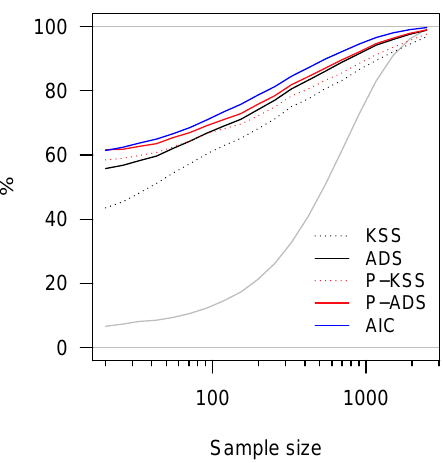
Fig. A1. Skewness-kurtosis diagram comparing the possible shapes Fig. A2. Simulation study: Number of times where the GD is se- Fig. 16. Skewness-kurtosis diagram comparing the possible shapes of the GD and WD, together with the normal of the GD and WD, together with the normal and exponential dis- Fig. 17. Simulation study: Number of times where the GD is selected as the preferred model, with the measures lected as the preferred model, with the measures KSS, ADS, P-KSS, tribution. The black line is the limit of all distributions. P-ADS and AIC. The gray line gives the rejection rate of the WD, and exponential distribution. The black line is the limit of all distributions. KSS, ADS, P-KSS, P-ADS and AIC. The gray line gives the rejection rate of the WD, according to GOF with according to GOF with ADS.